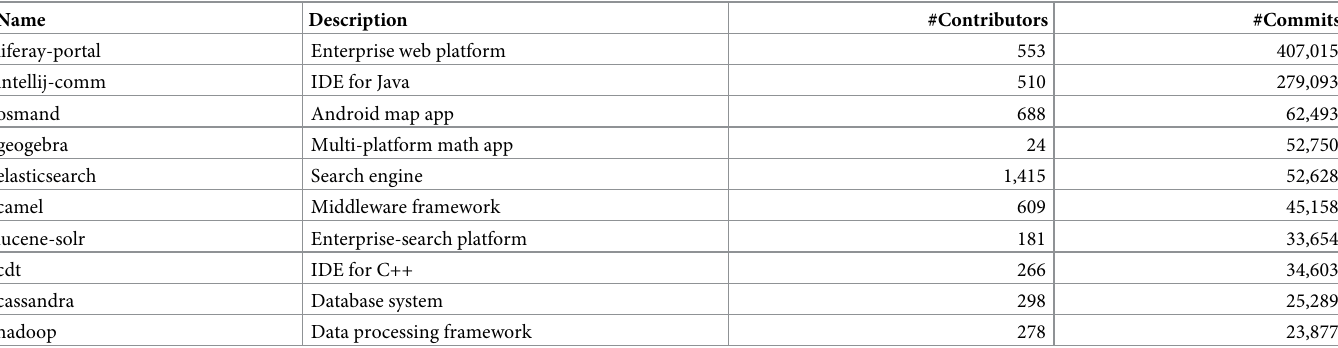
Table 2. Projects used in the